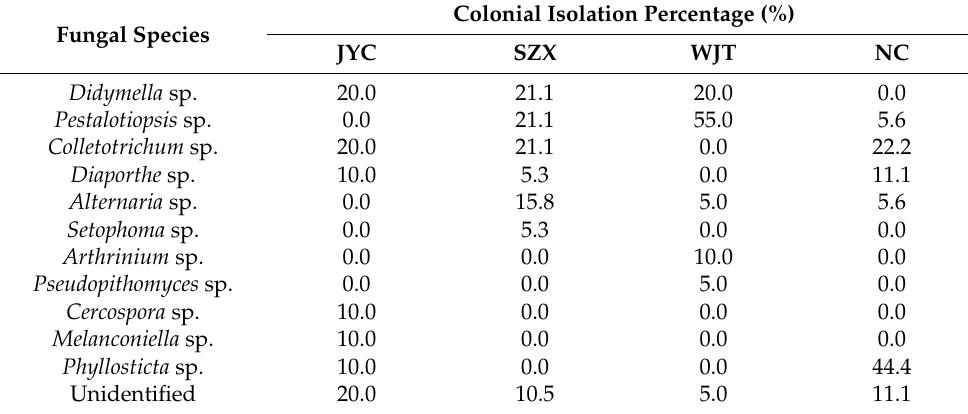
Table 1. Percentage of fungal colonies isolated from the sequenced samples. Fungal